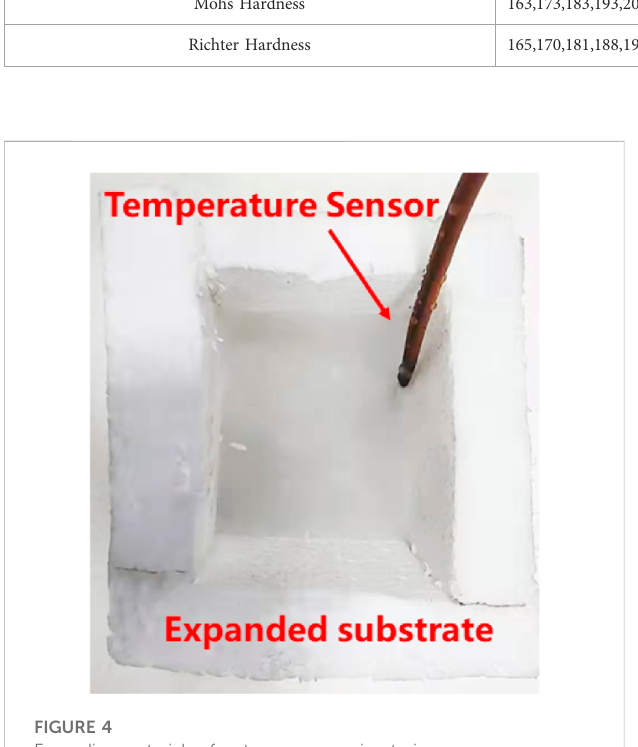
FIGURE 4 Expanding materials of water on conversion to ice.